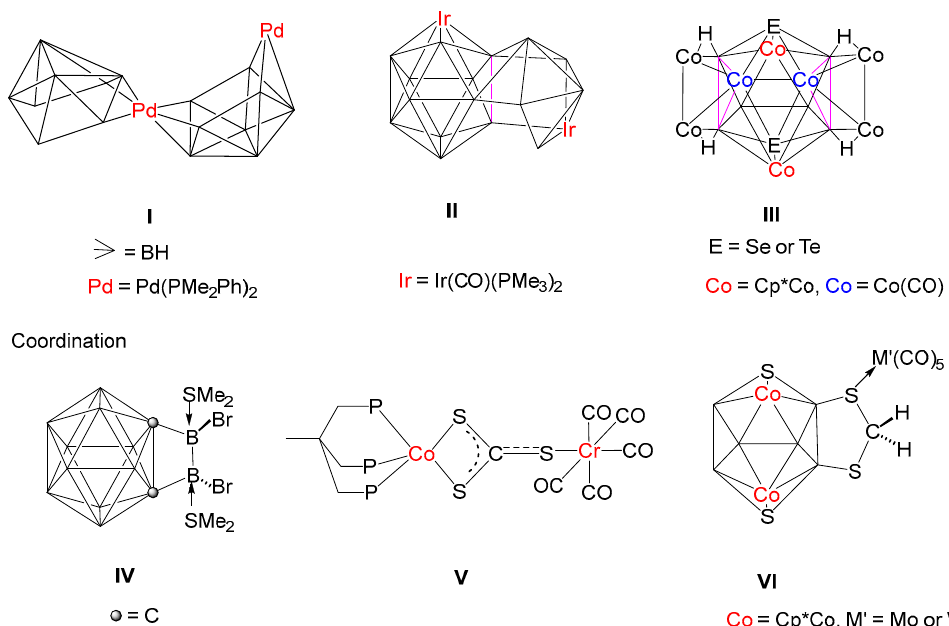
Chart 1. Different types of cluster expansion and